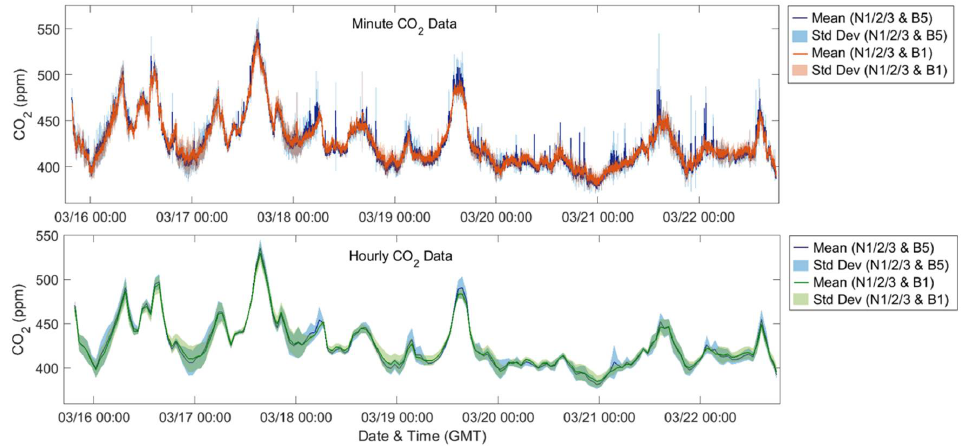
Figure 10. Time series of CO 2 data ( top : minute-median, bottom : hourly-averaged), showing the mean and standard deviation of different sets of Y-Pods.